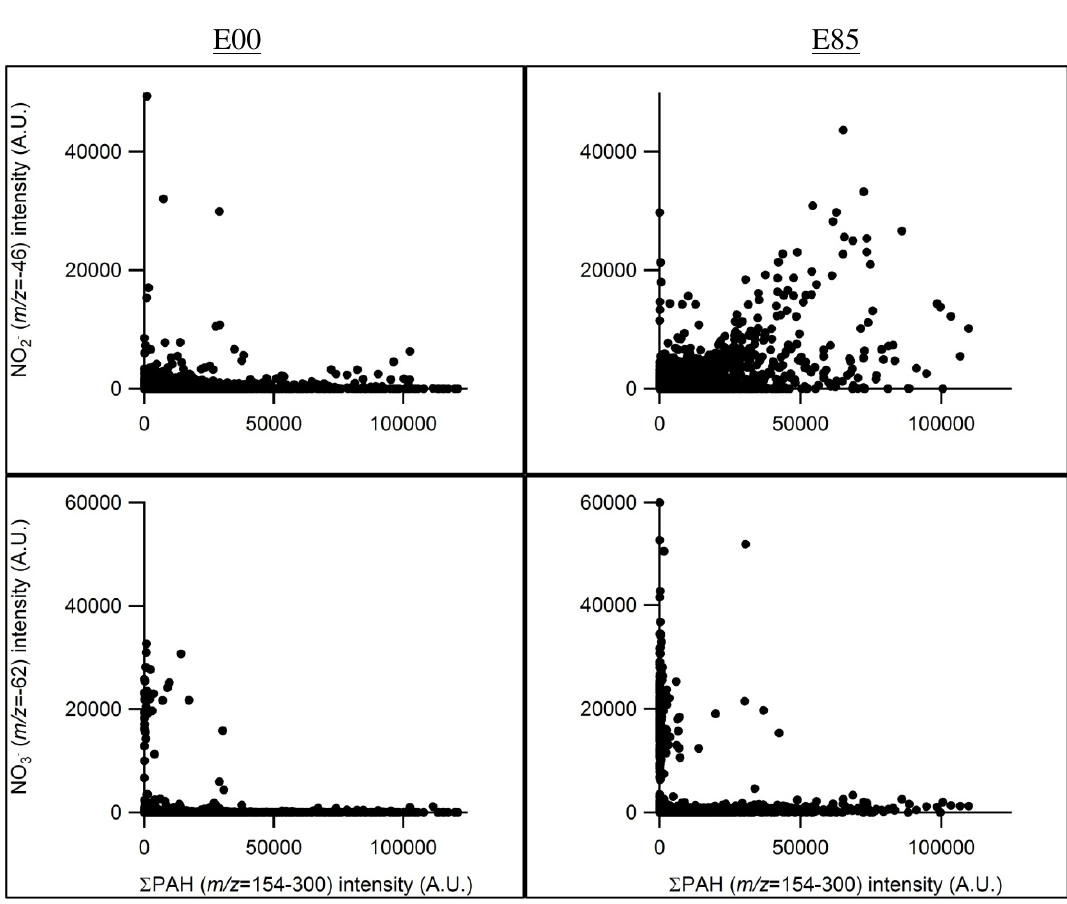
Figure 4. NO 2− , NO 3− and PAH relative peak area scatter plots. Each point represents data from the mass spectrum of a single particle detected in the E00 and E85 experiments, as indicated